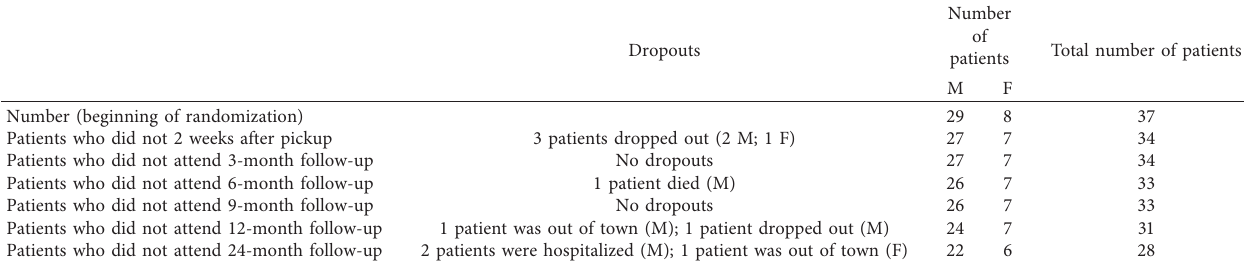
Table 3: Number of patients after randomization for the CM-LOC attachment group.